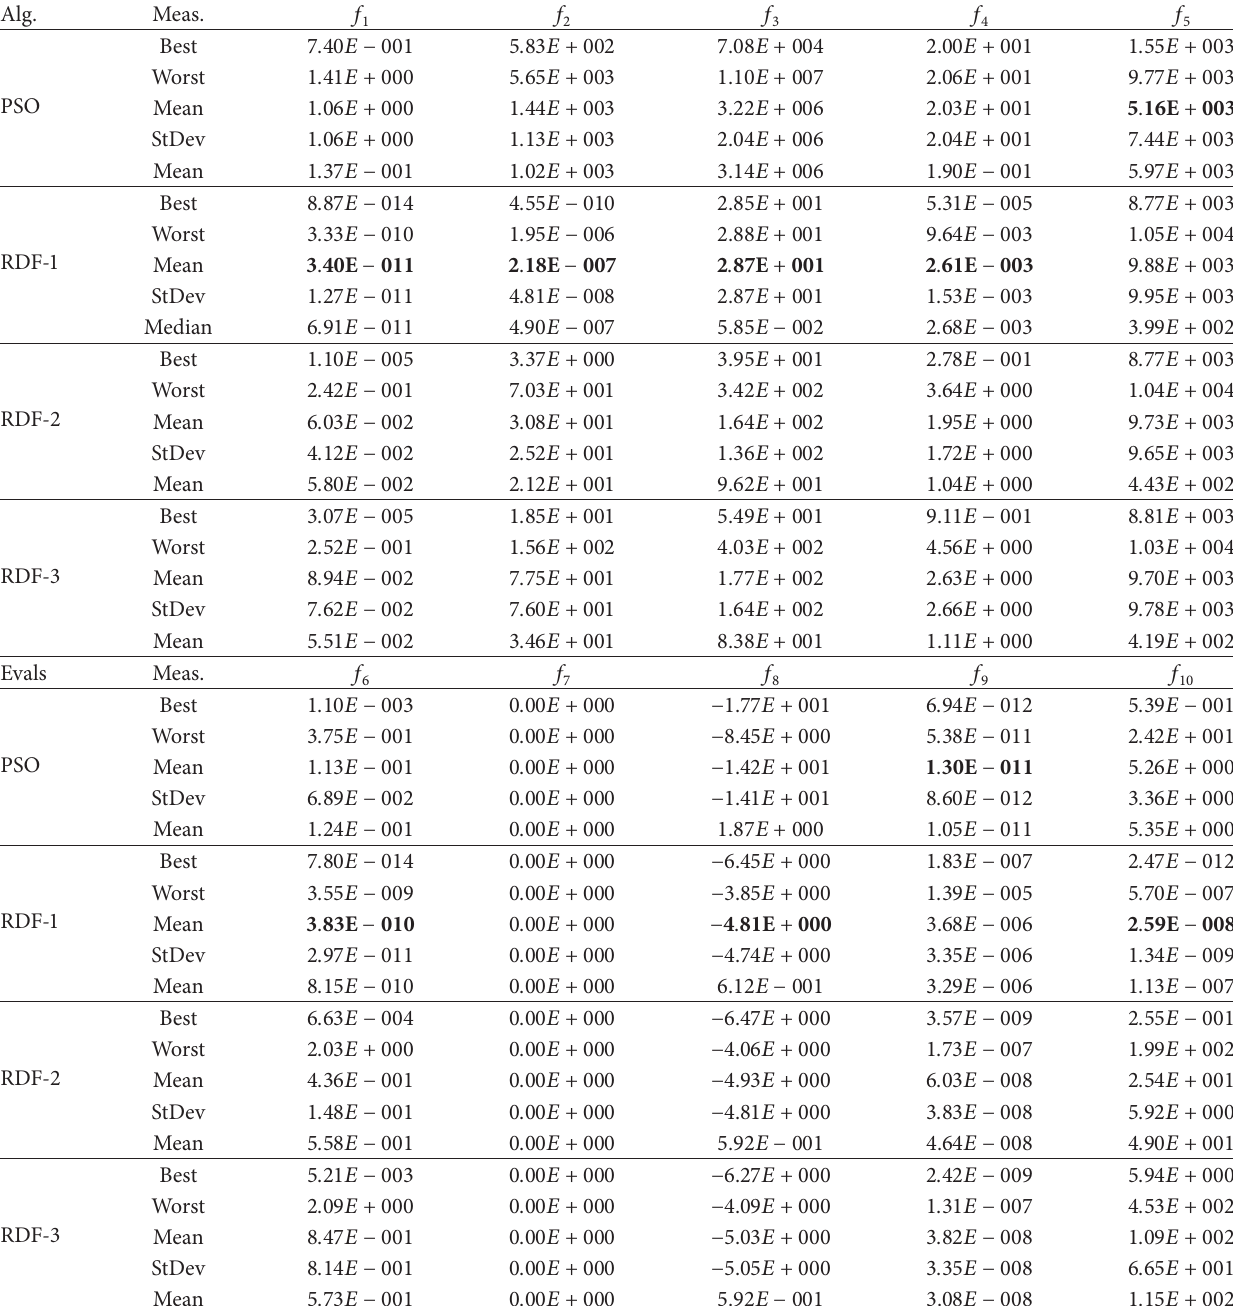
Table 3: Comparing the results of different PSO algorithms ( 𝐷 = 30